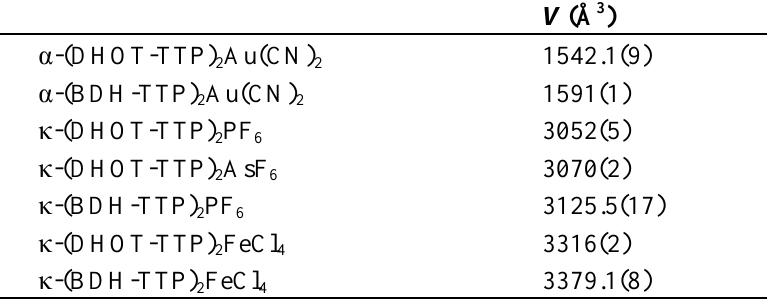
Table 1. Unit cell volumes of α- and κ-salts of DHOT-TTP and